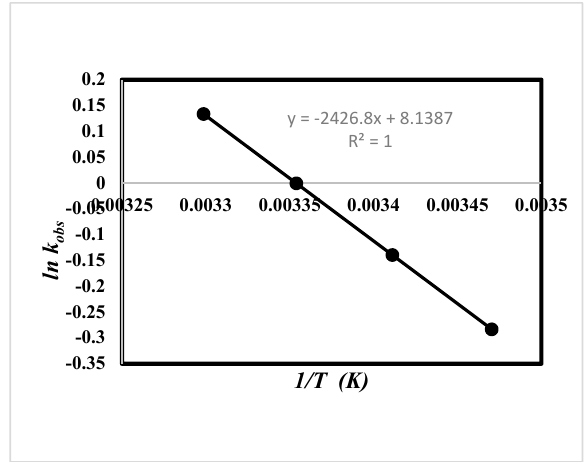
a Dielectric constant (D). b1 According to Equation (9). b2 According to Equation (8). c According to this equation: Ea = Δ H ‡ + RT. d In accord with the Arrhenius equation.